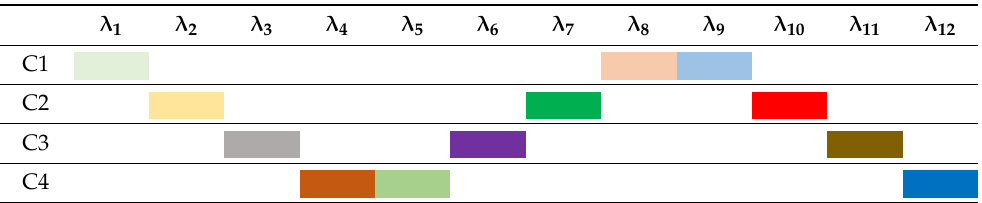
Table 3. 2D-MD spectral code